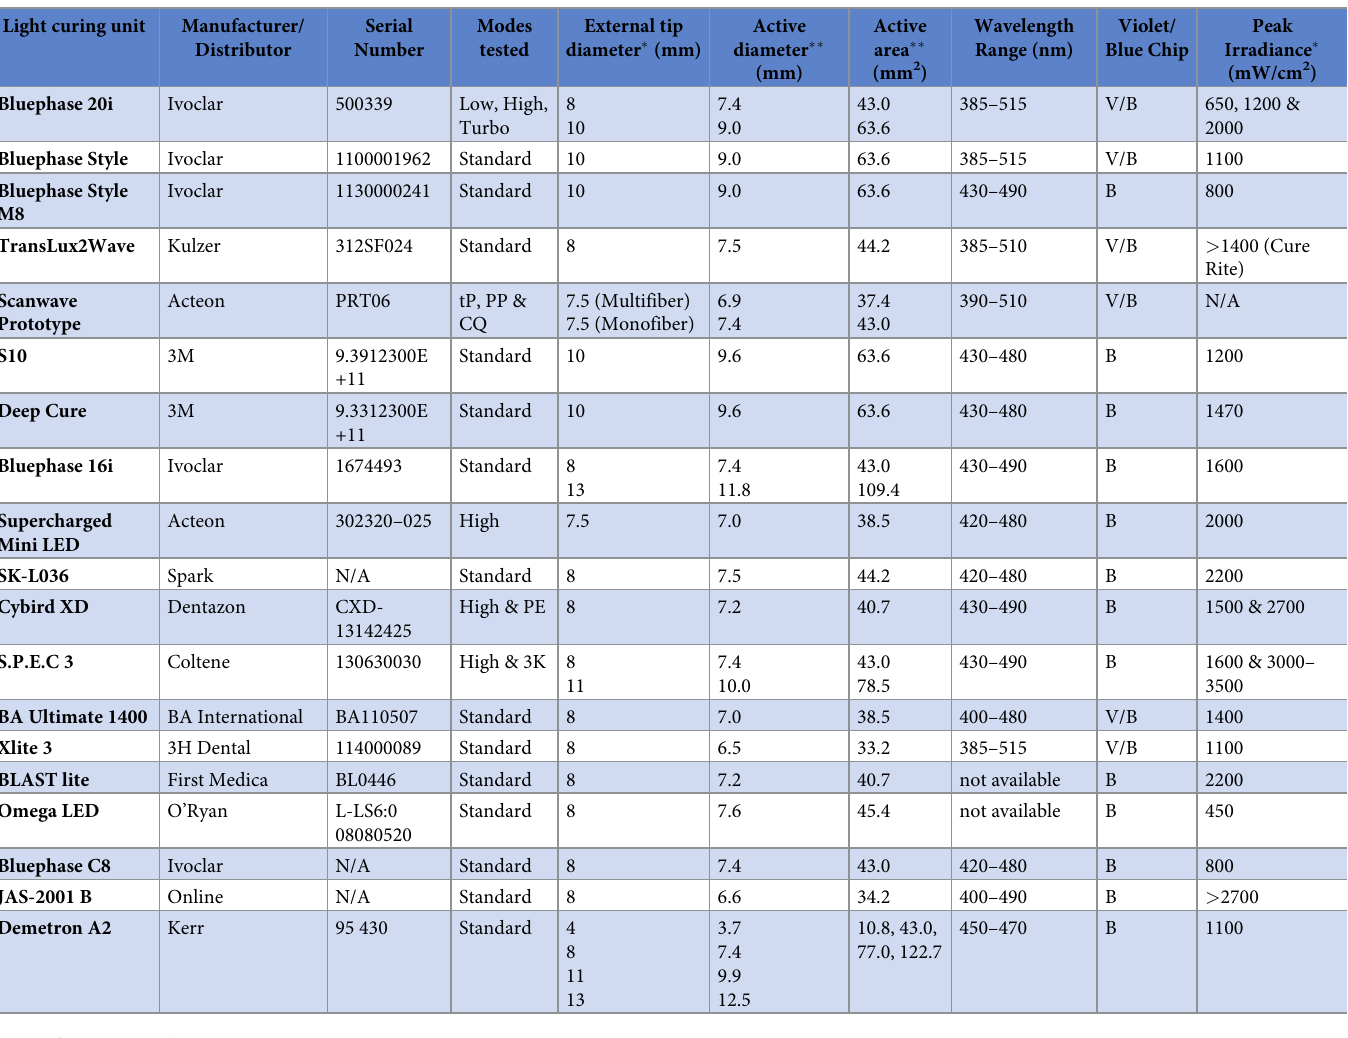
Table 1. Type I LCU optical properties and